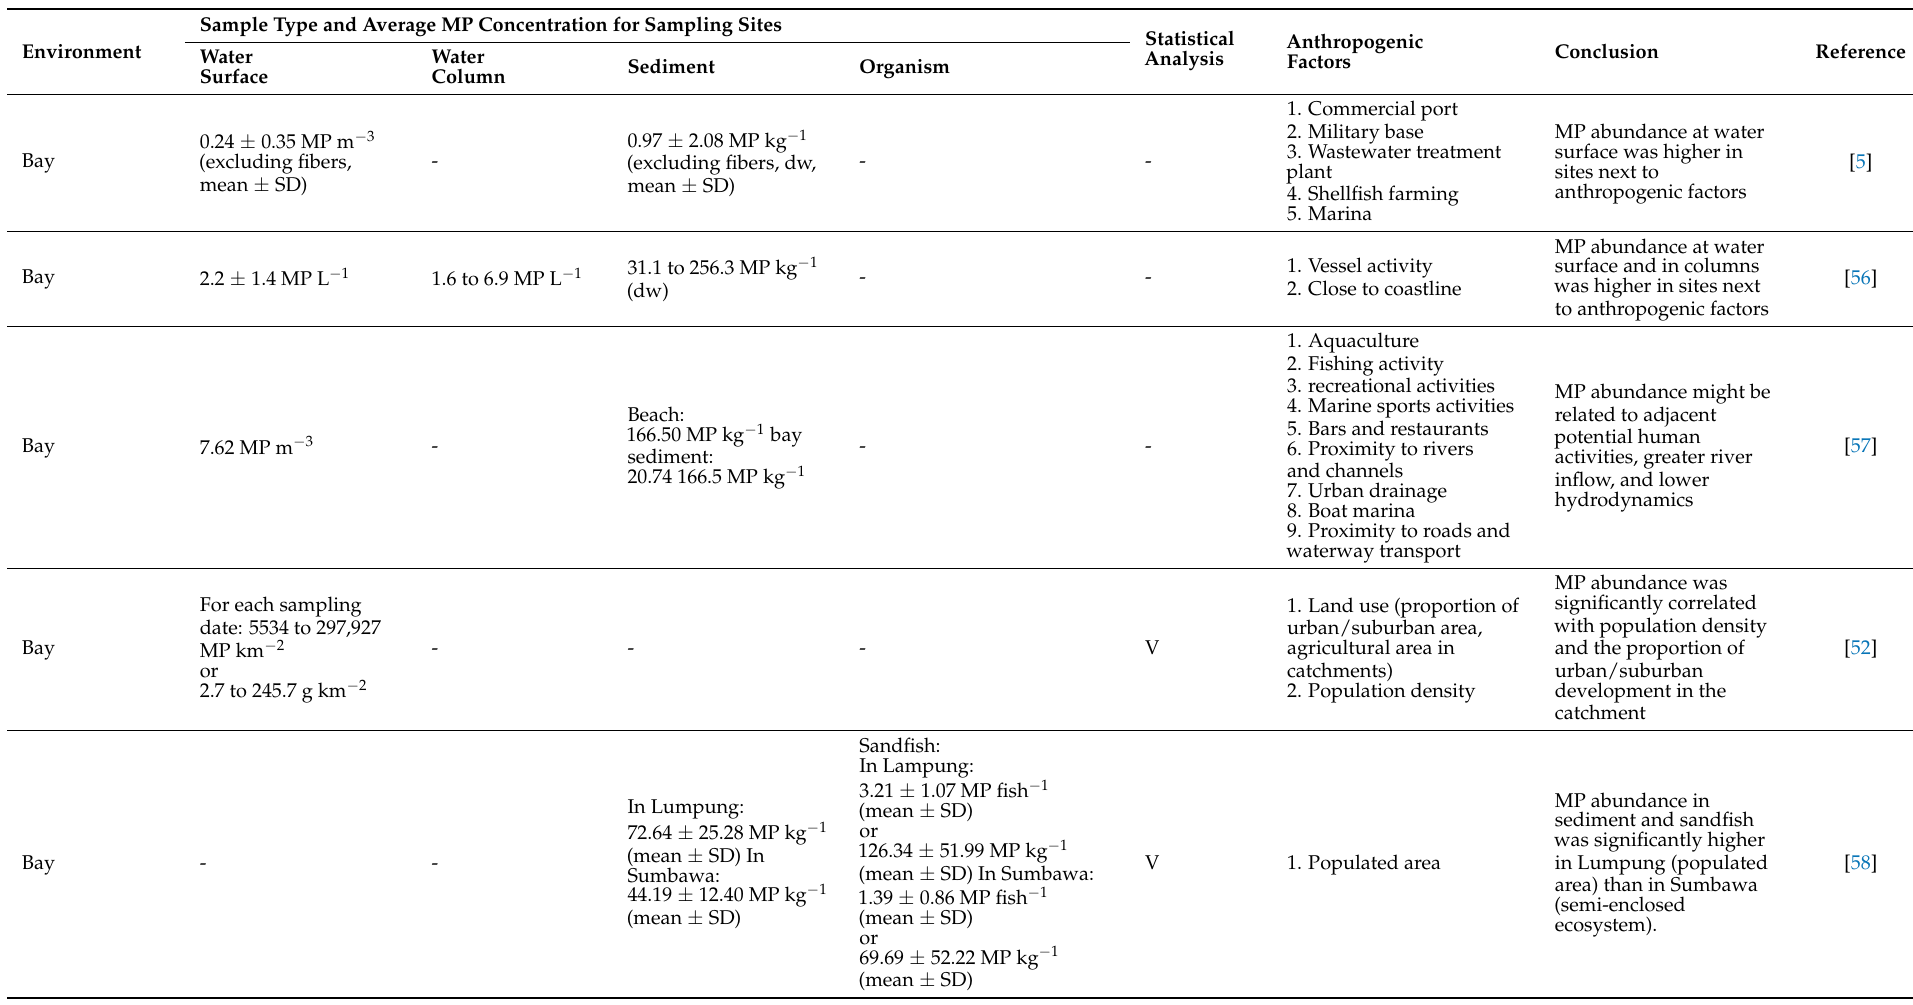
Table 1. Sampling condition, quantitative data and quantification strategies of anthropogenic activities in microplastic (MP) studies in aquatic environments. Note: dw, dry weight; ww, wet